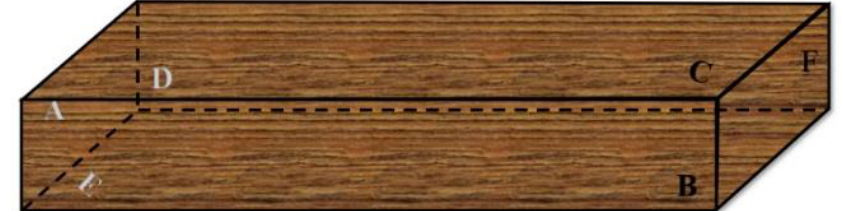
Figure 2. The three-dimensional model of the timbers. A and F are the left and right sides, E and C represent the bottom and top sides with 381 mm width, B and D denote the front and back sides with 101.6 mm thickness.